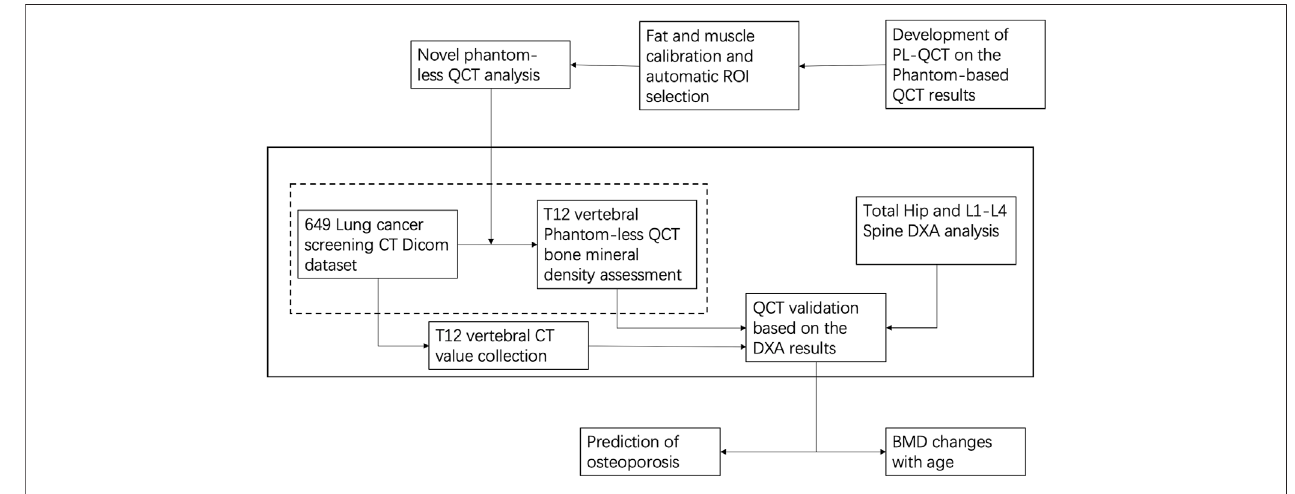
FIGURE 3 | Flow chart of the testing process in the whole project.